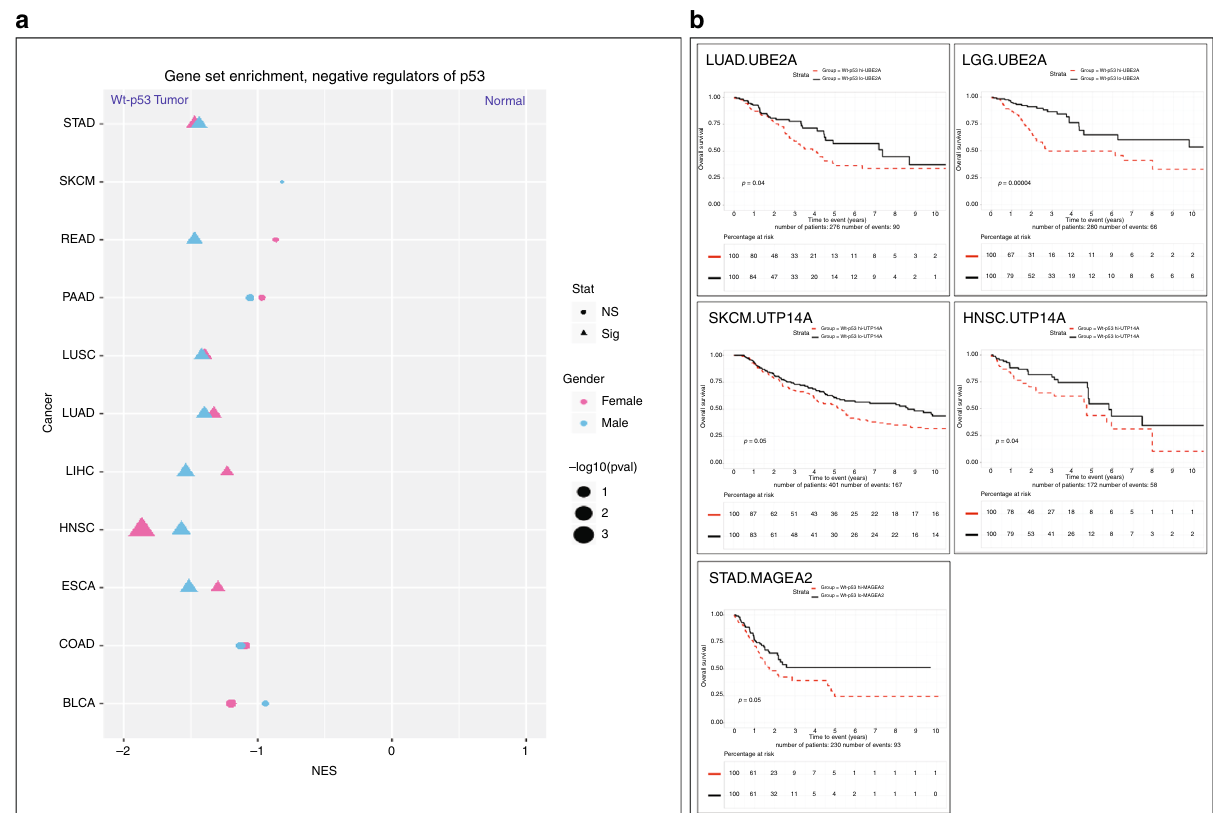
Fig. 5 High expression levels of negative regulators of p53 among the p53-STRING set are more frequent in wt TP53 cancers and associate with reduced survival. a Gene set enrichment analysis (GSEA) of the expression of the X-linked negative regulators of p53 compared between the disparity cancers with wt Tp53 and their matched normals. b Kaplan – Meier survival curves were generated for cancer patients with wt Tp53 tumours on the basis of the relative expression levels of the X-linked p53-negative regulators UBE2A, UPT14A and MAGE2A, respectively (top median: broken red line and bottom median: solid black